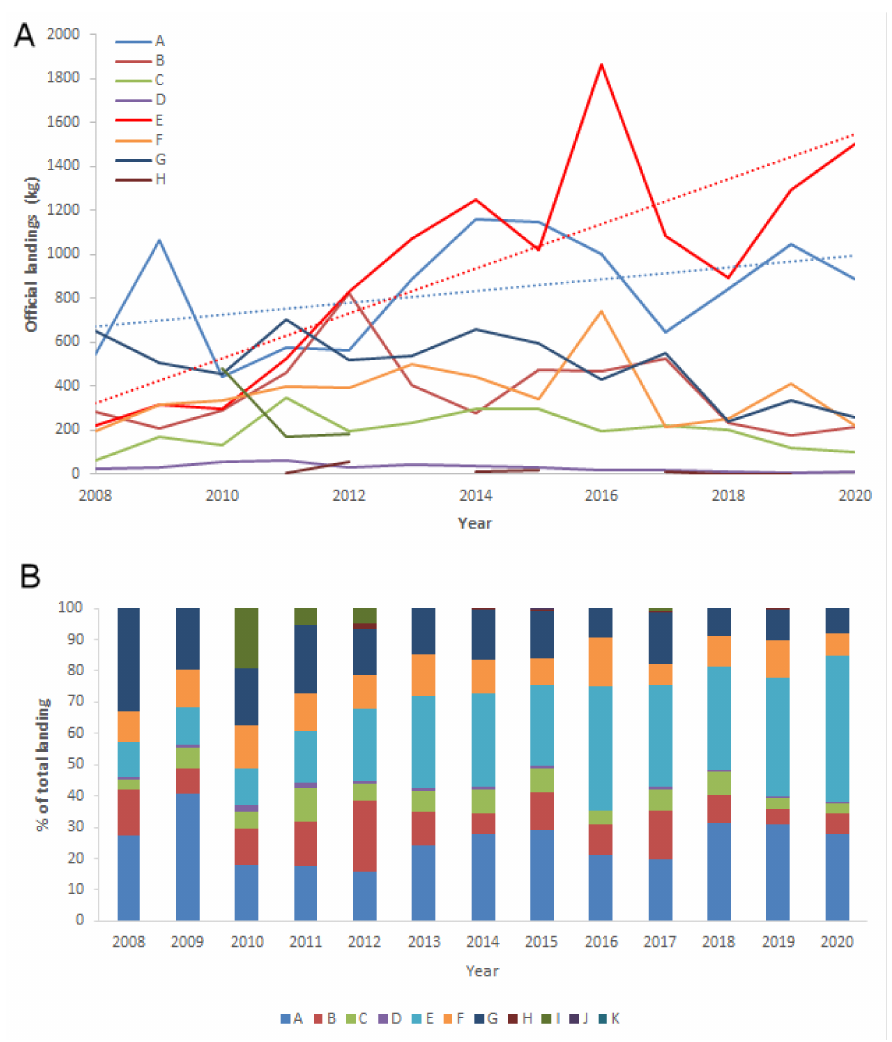
Figure 2. ( A ) Official landings of the European lobster, Homarus gammarus (Croatian Fisheries Directorate 2008–2020) with the indicated trends in fishing zones A and E. ( B ) Percentage of landed catch in each fishing